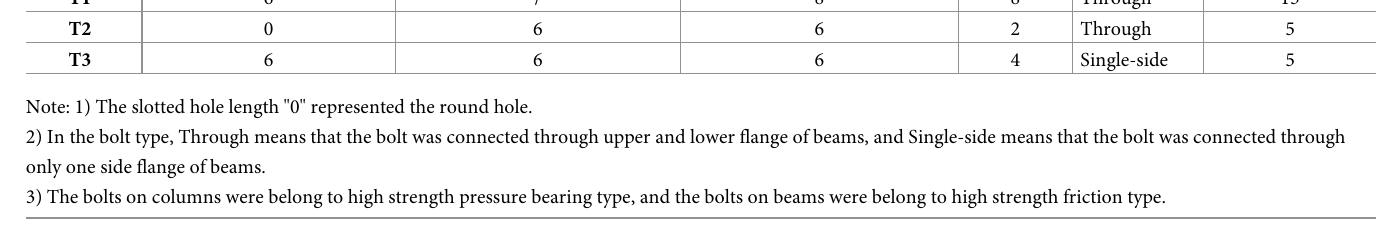
hexagon bolts with an anti-slip coefficient of 0.45 and connected with hex nuts and washers of the same grade and diameter. The total length of the bolts was 14cm. All GFRP columns were made of 8.8-grade M12 high-strength through bolts. The details of the specimens were shown in Table 1. The parameters of Young’s modulus, Poisson’s ratio and compressive strength of various materials were measured by experiments, and the results were listed in Table 2. Test equipment and loading system. The test loading device was a single channel elec- tro-hydraulic servo loading system. The level of actuator deformation range was 200 mm, which could exert the maximum load of 250 kN. To facilitate loading, the GFRP column was fixed under the loading device. By applying a vertical displacement actuator in the beam end and connected actuator by a steel tube at GFRP beam loading point, it was to ensure the stabil- ity of loading position and keeping verticality of actuators. Solid wood blocks were inserted into GFRP beams to avoid local compression failure at loading points. Considering the gap between bolts and bolts holes during installation of specimens, a preloading test was carried out first. The loading device was shown in Fig 3. Displacement recorded by displacement meters set at different distances along GFRP beam from the joint to calculate the rotation angles of joints according to Eq (1):